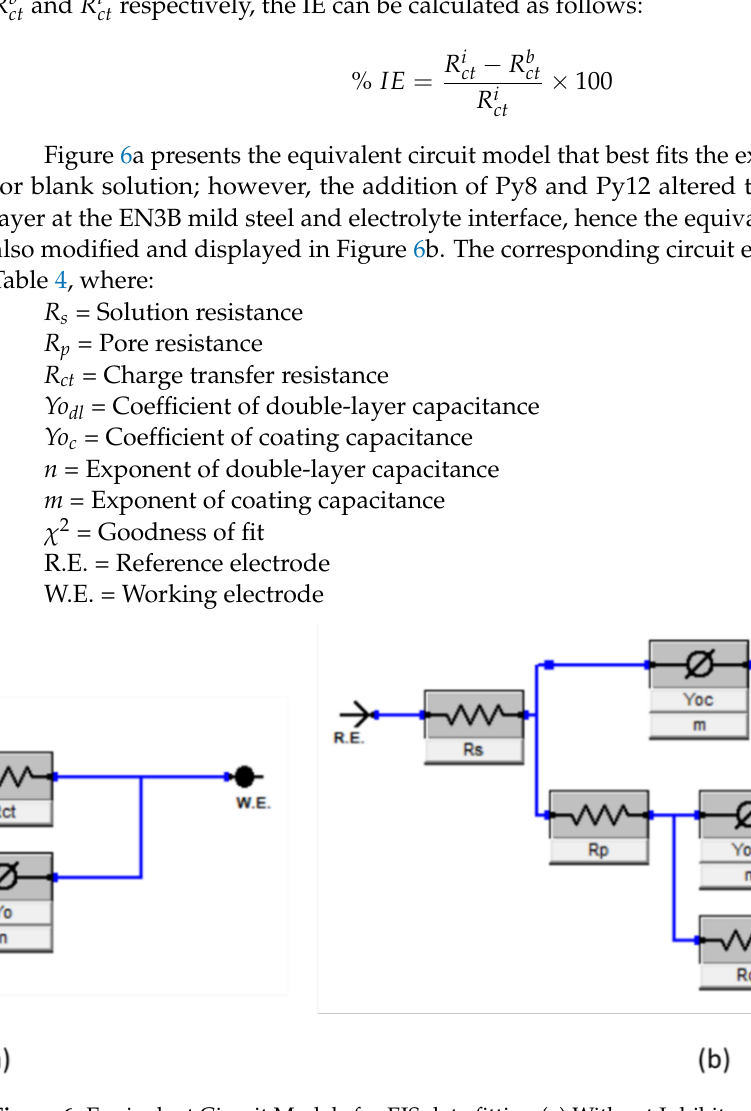
Figure 6. Equivalent Circuit Models for EIS data fitting ( a ) Without Inhibitor ( b ) With Inhibitor. Table 4. EIS parameters for EN3B mild steel at varying concentrations of Py8 and Py12 in 3.5% NaCl solution (pH = 1.5).